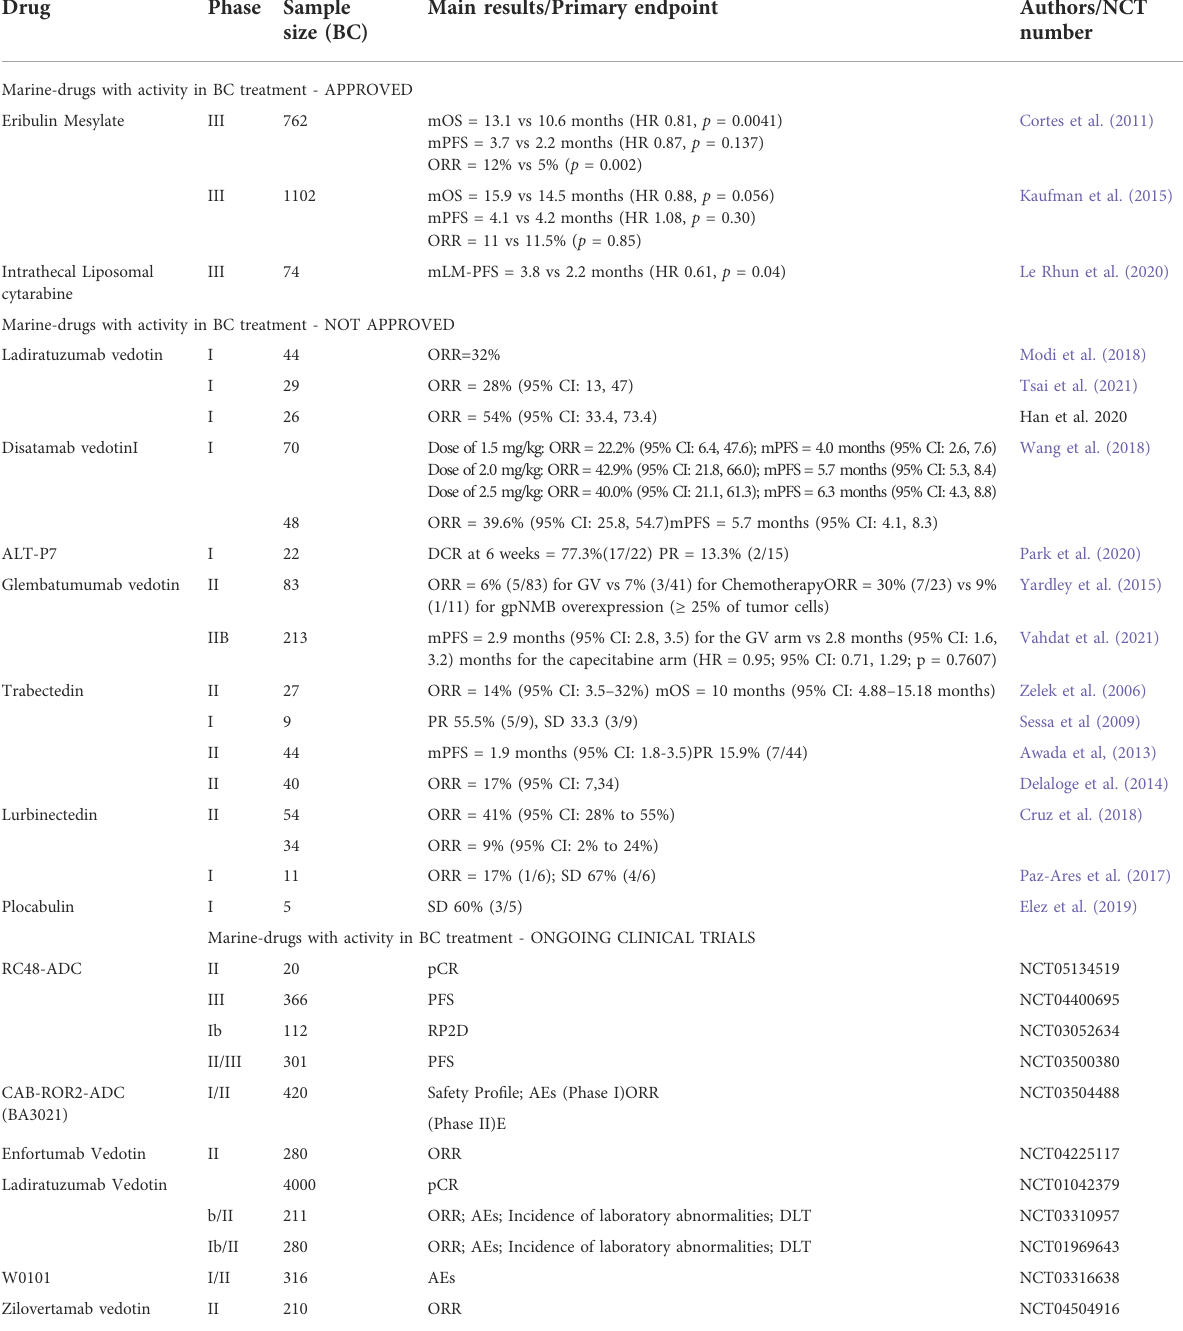
TABLE1Studiesonmarine-derivedcompoundsinbreastcancer.Abbreviations:TPC,treatmentphysician ’ schoice;BC,BreastCancer;ABC,advanced breast cancer; LA, locally advanced; HR, Hormone Receptor; TNBC, triple-negative breast cancer; LM, leptomeningeal metastasis; OS, overall survival; ORR, objective response rate; PFS, progression free survival; DCR, disease control rate; pCR, pathological complete response; PR, partial response;SD, stable disease;DTL, Dose Limiting Toxicity; AE, AdverseEvents; MTD, maximal tolerance dose; RP2D, recommended phase II dose; NA, not